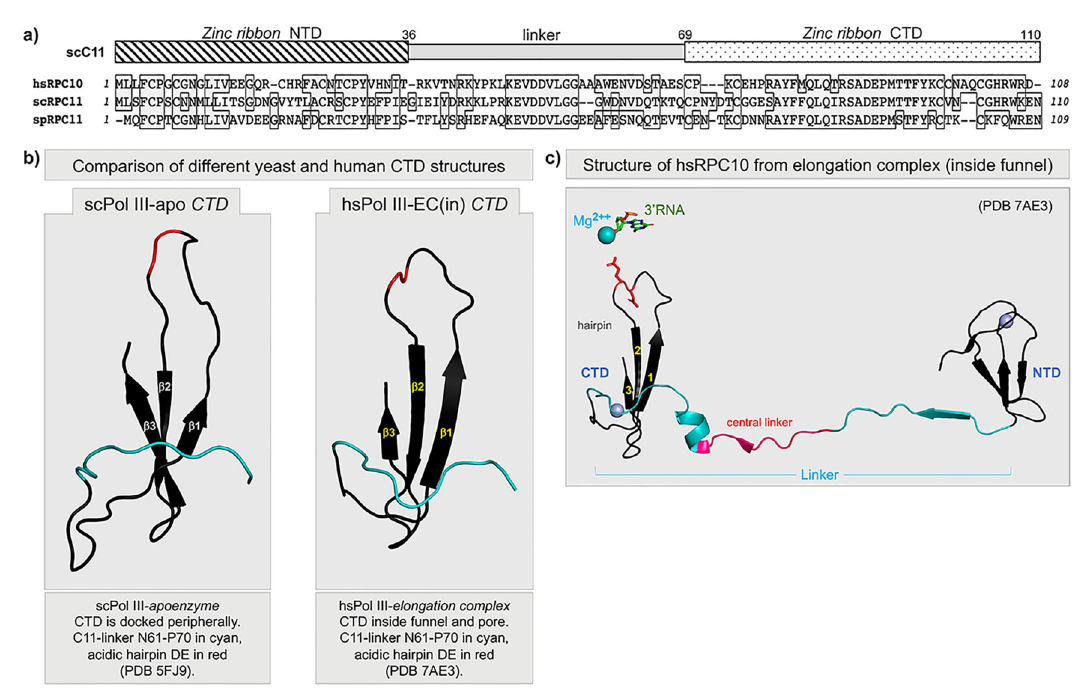
Fig. 1 Sequence and structure conservation of RPC11 and RPC10 homologous subunits of yeast and human Pols III. a Top: schematic of the three conserved domain structure consisting of an N-terminal domain (NTD) and a C-terminal domain (CTD) each comprised of a Cys-4 Zinc ribbon, connected by a linker domain. Bottom: alignment of the human (hs), S. cerevisiae (sc), and S. pombe (sp) sequences; identical amino acids are in shaded boxes. b Comparison of the C11 CTD taken from the S. cerevisiae Pol III apoenzyme (PDB 5FJ9) 41 , and RPC10 CTD taken from the human Pol III elongation complex (inside the funnel conformation) (PDB 7AE3) 43 . The distal linkers are colored cyan and the positions of the acidic hairpin amino acids are in red. c Full- length RPC10 taken from the human Pol III elongation complex showing the NTD, extended linker, and CTD in the inside the funnel and pore position (PDB 7AE3). The acidic hairpin Glu-89 is shown in red stick format pointing toward an active site Mg ++ (cyan sphere, at >7.5 Å) and the RNA 3 ′ nucleotide (stick format) which was noted to be too distant for interaction in this context 43 . The linker is comprised of a proximal part with a beta-strand colored cyan, an invariant central linker colored red, and a distal part with a short helix and extending beyond, in cyan. The two zinc molecules, one with the NTD and one with the CTD, are shown as gray